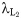
Linear and non-linear correlation networks of the number of Human Rights Violations (HR Violations), Homicide Rate (HR) per 100,000 inhabitants, Unemployment Rate, Gini Coefficient, number of gangs Ng and the leading λL and second leading λL2 eigenvalues of the adjacency matrix.Edges’ thickness is proportional to r, ρ coefficients (the thickest edge corresponds to the r = 0.943 correlation between the Gini Coefficient and Ng whereas the thinest edge corresponds to r = 0.625 correlation between the Gini Coefficient and the Unemployment Rate. Only correlations satisfying r, ρ ≥ 0.6 and p ≤ 0.07 were considered.